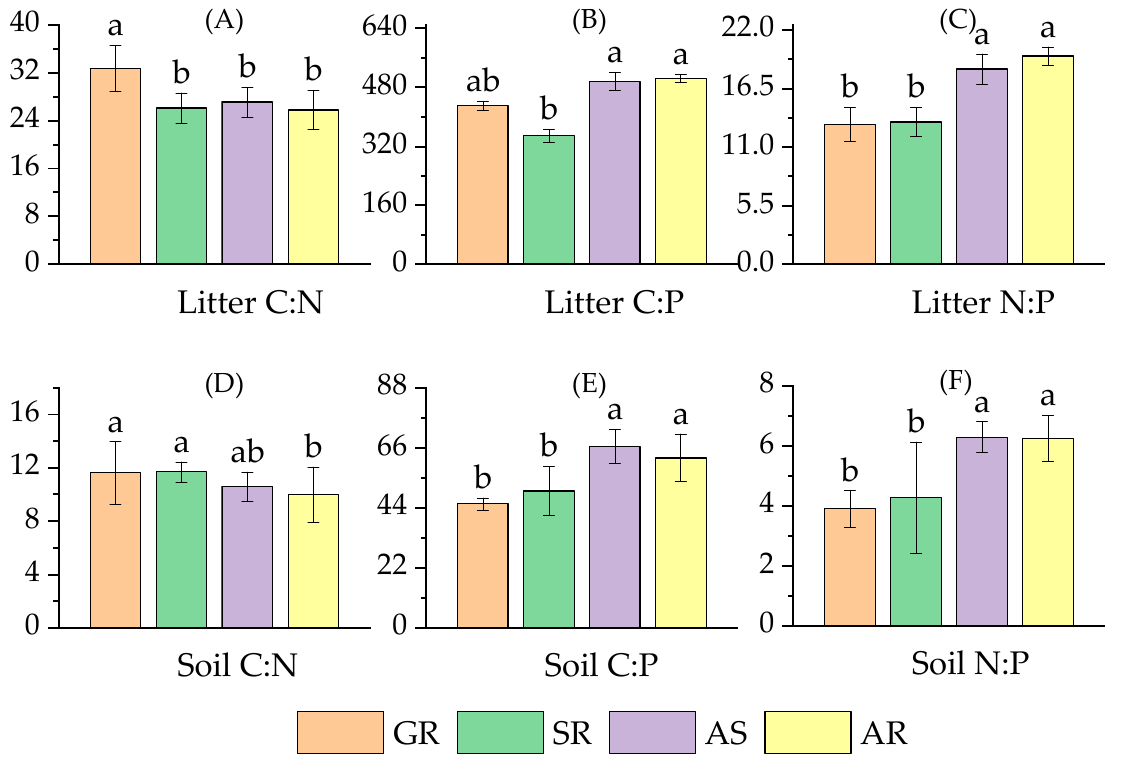
Figure 3. The ecological stoichiometric characteristics of litter and soil in different vegetation types. Note: Subfigure ( A ) = litter C:N ratio in different vegetation types, subfigure ( B ) = litter C:P ratio in different vegetation types, subfigure ( C ) = litter N:P ratio in different vegetation types, subfigure ( D ) = soil C:N ratio in different vegetation types, subfigure ( E ) = soil C:P ratio in different vegetation types, and subfigure ( F ) = soil N:P ratio in different vegetation types. GR = grassland, SR = shrubland, AS = arbor and shrub compound forest, and AR = arbor forest. The error bar shows the standard deviation of the average. Different lowercase letters indicate significant differences at the 0.05 level ( p < 0.05) between different vegetation types.